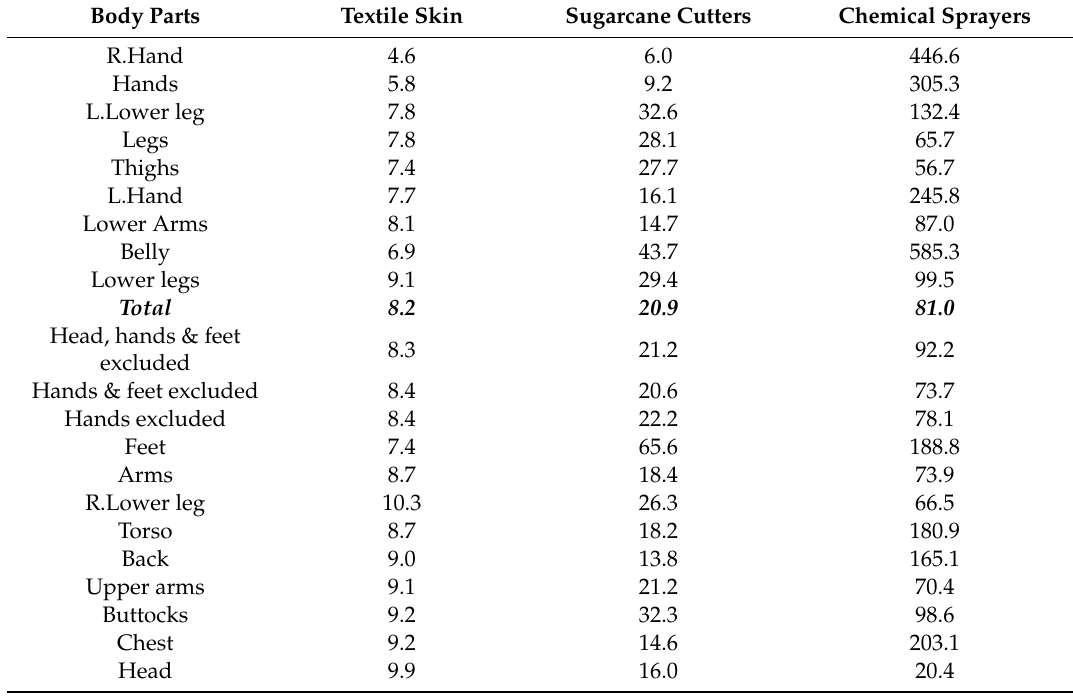
Table 3. Corrected total evaporative resistance of the whole body, body regions and individual zones (m 2 Pa /